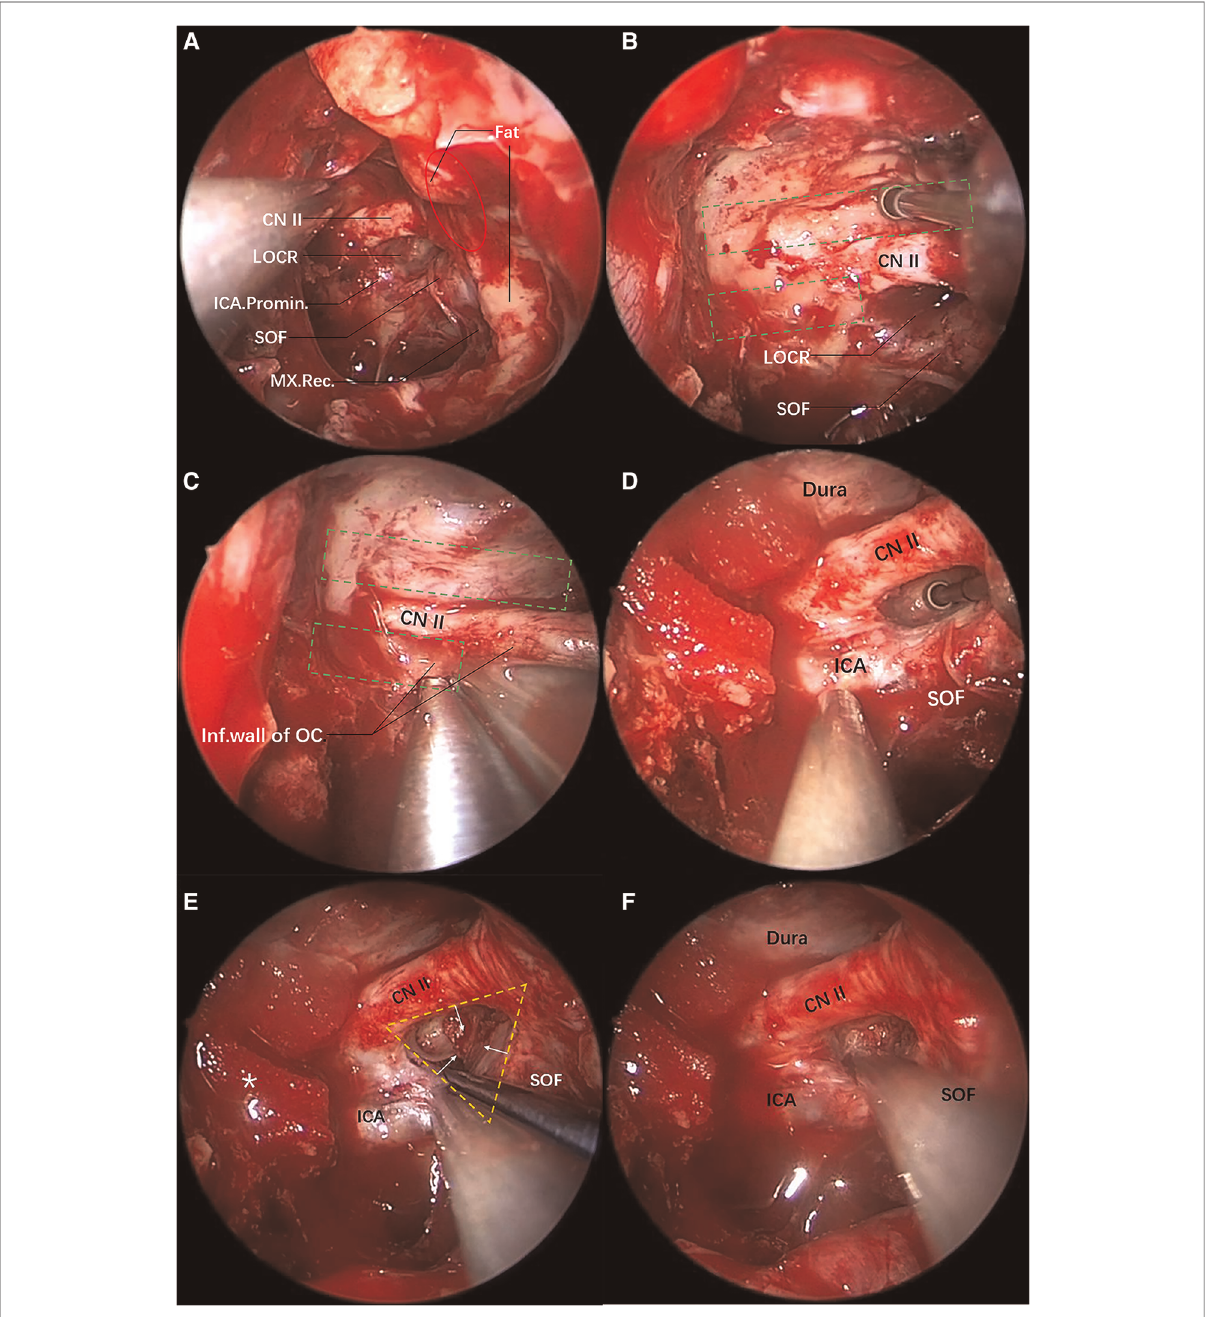
FIGURE 3 Transnasal endoscopic decompression of oculomotor nerve through the optic strut. The yellow dotted triangle area denotes the range of the optic strut triangle, and the red oval area the range of the orbital apex. ( A ) View of the lateral wall of the left sphenoid sinus after the anterior wall of the sphenoid sinus is opened under the transnasal endoscope. The sphenoid sinus pneumatization is good on the left side, LOCR is an obvious depression and its three sides are the ICA, the superior orbital fi ssure and the optic nerve, respectively. The fat in the orbital apex is exposed due to traumatic fractures. There is a depression below the superior orbital fi ssure, namely a maxillary strut depression, which is the inferior margin of the superior orbital fi ssure. ( B ) The superior wall bone of the optic nerve is eggshelled and the anterior skull base dura mater is exposed. The green dotted rectangle (top) denotes the drilling range. ( C ) The inferior wall bone of the optic nerve is eggshelled. The inferior wall bone is removed with a gun-shaped rongeur. The green dotted rectangle (bottom) shows the drilling range. ( D ) The optic strut is eggshelled. ( E ) Three surfaces of the triangular prism-shaped optic strut are eggshelled. The eggshelled optic strut is peeled off using a detacher in the direction of the yellow arrow. The yellow dotted triangle is the optic strut triangle, and the asterisk on the left side indicates the gelatin sponge used for compression hemostasis of the superior intercavernous sinus. ( F ) Decompression is performed successively on the orbital apex, the superior orbital fi ssure, the optic canal and the optic